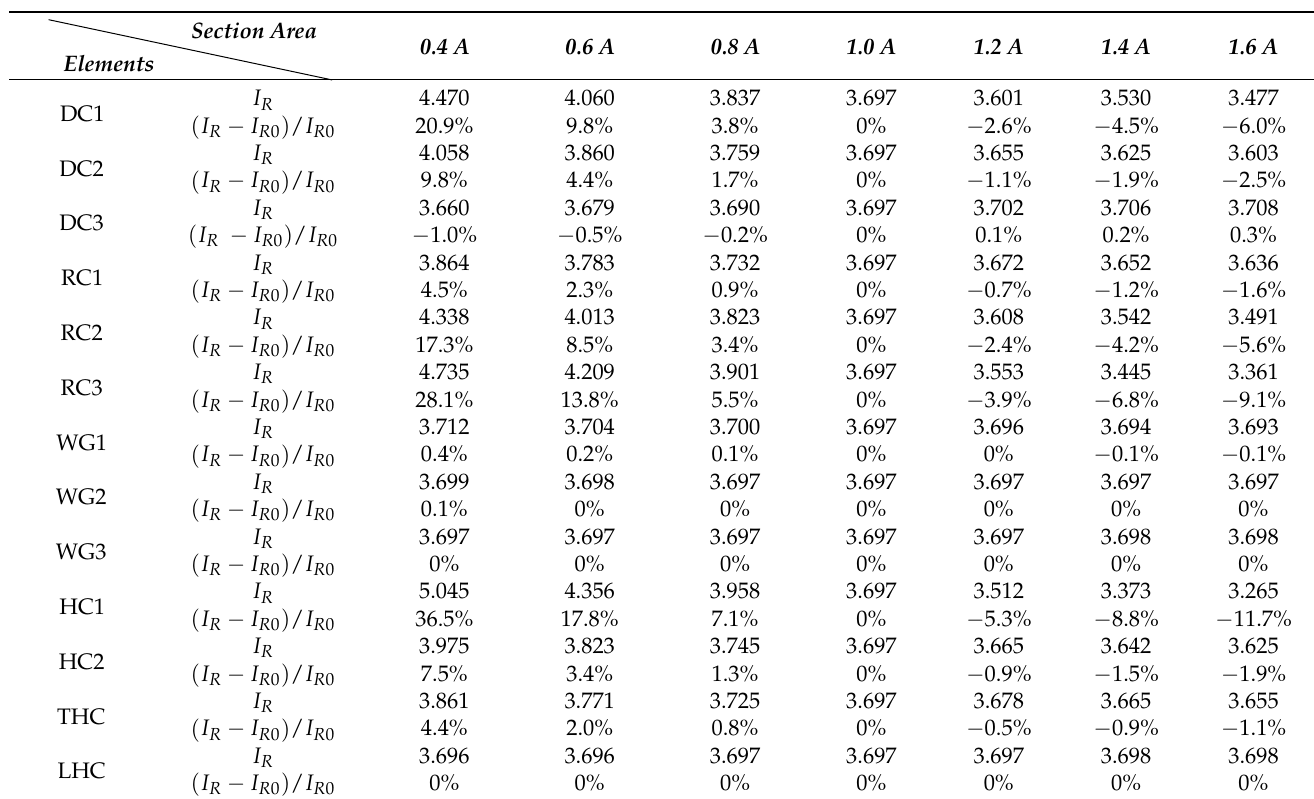
Table 3. Structural robustness indicator under various section-area of each kind of